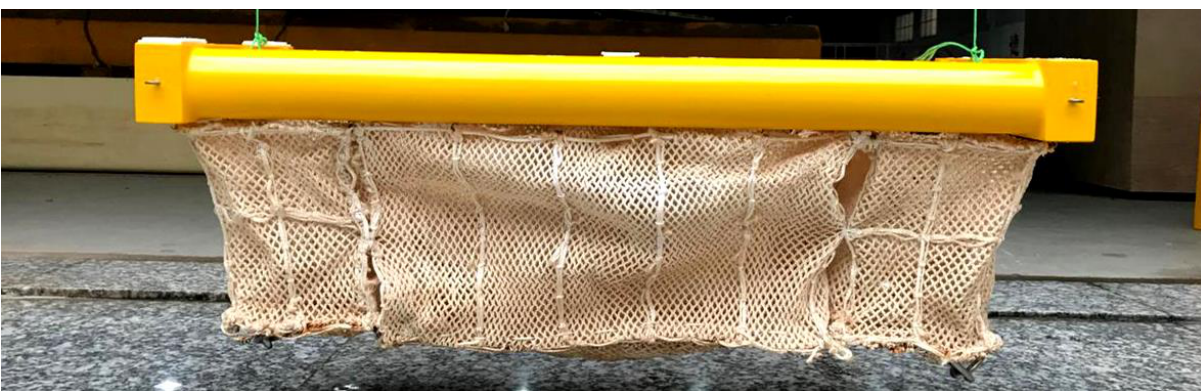
Figure 14. Front view of the floating breakwater model.